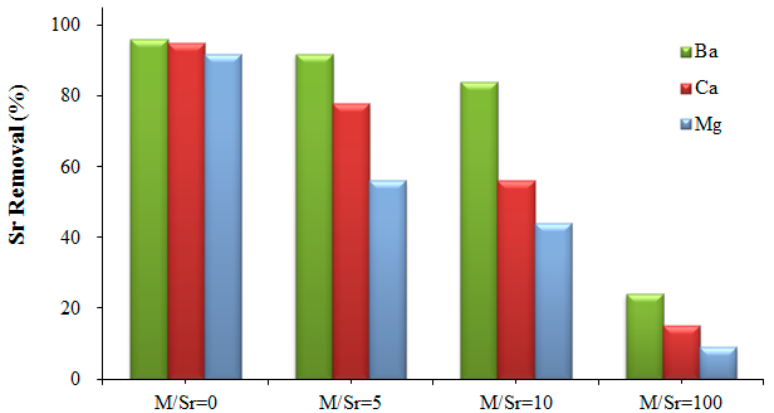
Figure 3. Effects of competitive ions on the Sr adsorption by the composite magnetic nanoparticles. Conditions: Adsorbent dose 5 g ∙ L − 1 , pH 10.25, T 298 K, ionic strength 0.5 mol ∙ L − 1 , contact time 120 min, Sr concentration 10 mg ∙ L − 1 .